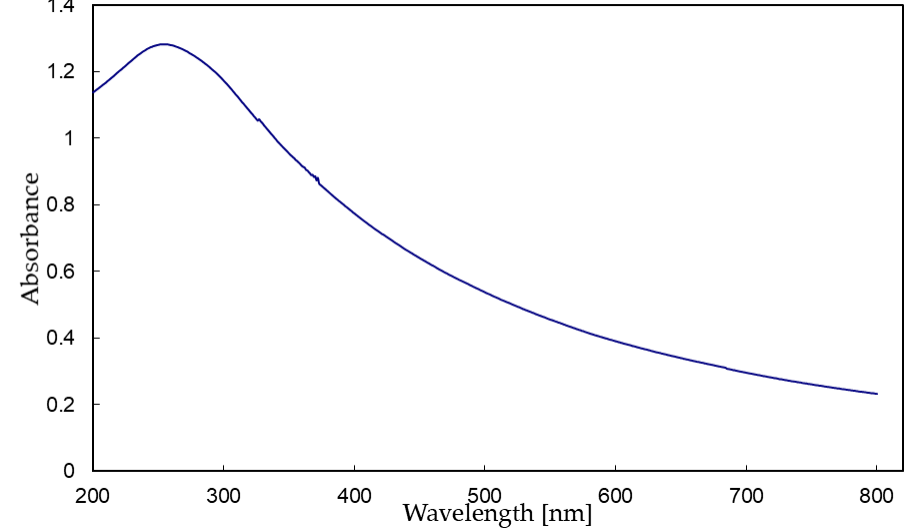
Figure 4. UV-VIS absorption spectra of TiO 2 planar particles.